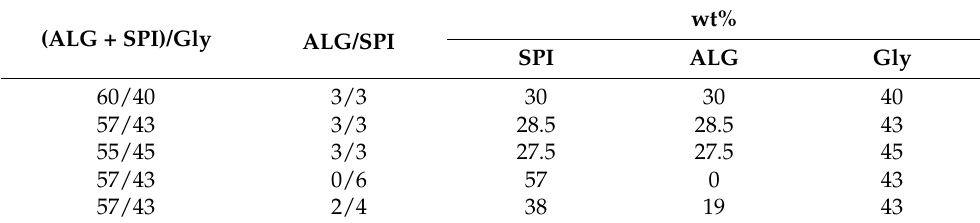
Table 1. Compositions of the different studied Alginic acid sodium salt (ALG) + soy protein isolate (SPI)/glycerol (Gly) blends. wt% (ALG + SPI)/Gly ALG/SPI SPI ALG Gly 60/40 3/3 30 30 40 57/43 3/3 28.5 28.5 43 55/45 3/3 27.5 27.5 45 57/43 0/6 57 0 43 57/43 2/4 38